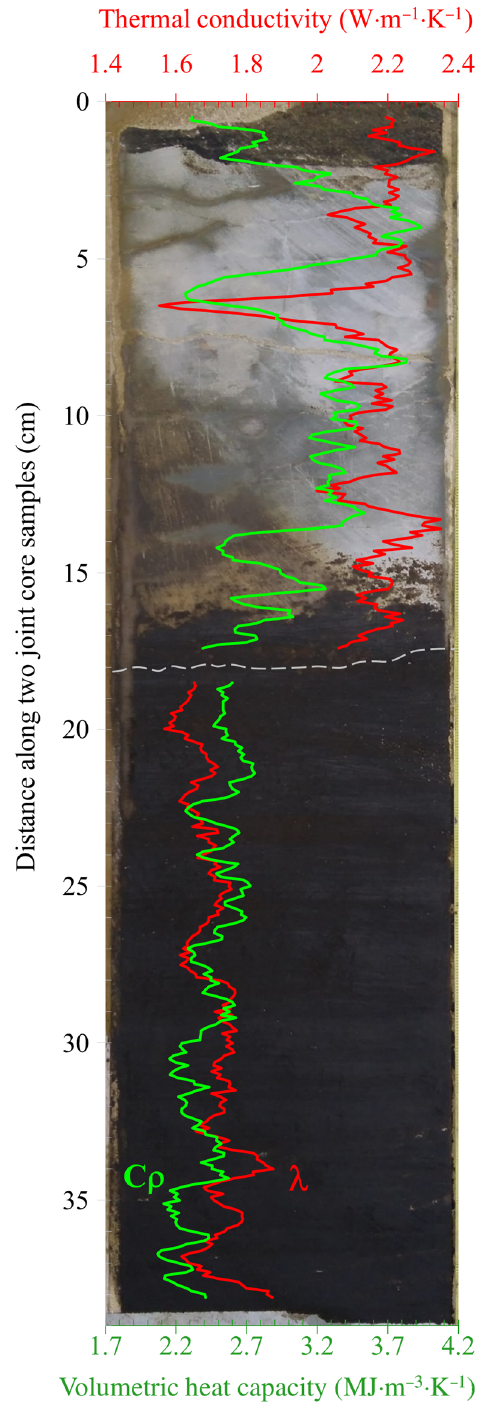
Figure 1. Example of thermal profiling results in two adjacent samples (the border is shown by a dashed gray line) with significant variations in thermal conductivity (red) and volumetric heat capacity (green), superimposed on a photo of slabbed samples (dark area identifies oil sand; light area—siltstone). CLTE was measured over a wide temperature range using a dilatometer with a quartz pusher DKT-40 (Chelyabinsk, Russia) , specifically designed for studies of 30 × 30-